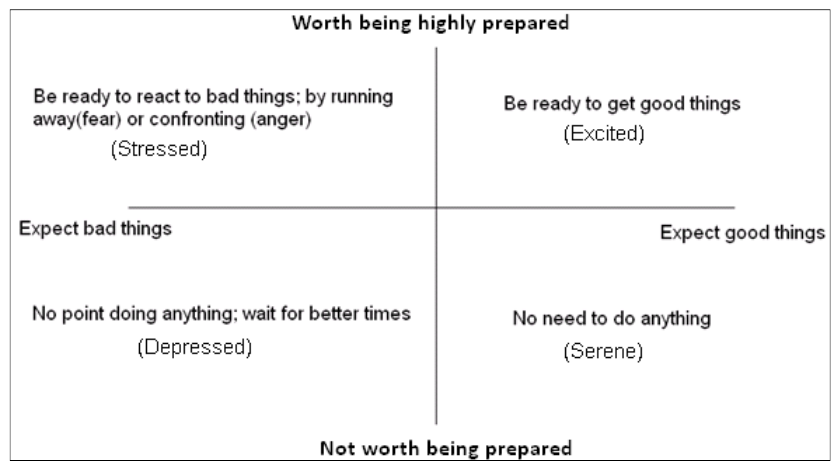
Figure 2. The basic functions of expectation and preparedness. Environmental cues can indicate the likely scenario (good or bad), so prepare the individual for deciding whether to approach or avoid new stimuli, and how ready to